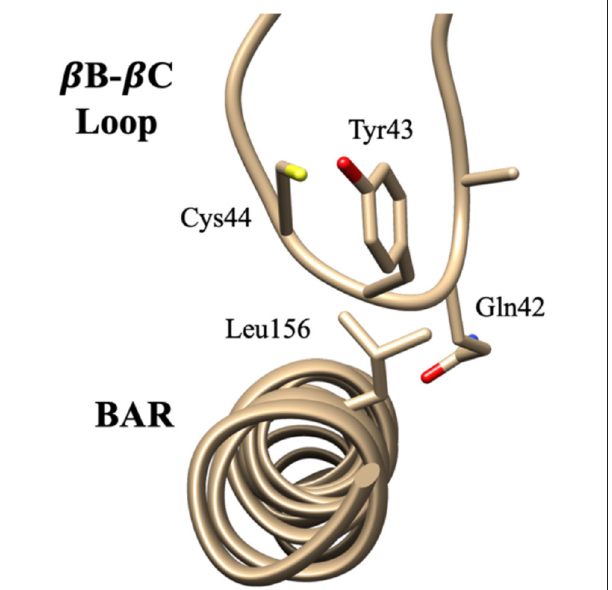
FIGURE 5 | Key interaction pairs between the PDZ domain and the BAR domain. Visualization of key interaction pairs between the PDZ β B- β C loop and the BAR domain (Gln42-Leu156, Tyr43-Leu156, and Cys44-Leu15) listed in Table 2